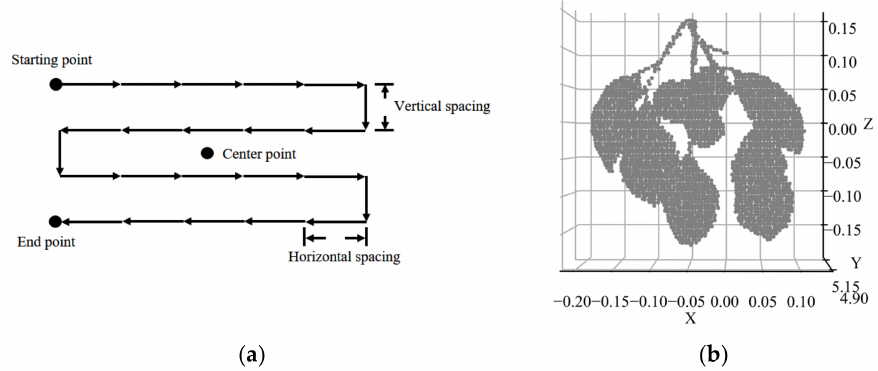
Figure 3. HSL scanning strategy and persimmon tree scan points. ( a ) The zigzag scanning pattern of HSL; ( b ) preprocessed HSL point cloud of the persimmon